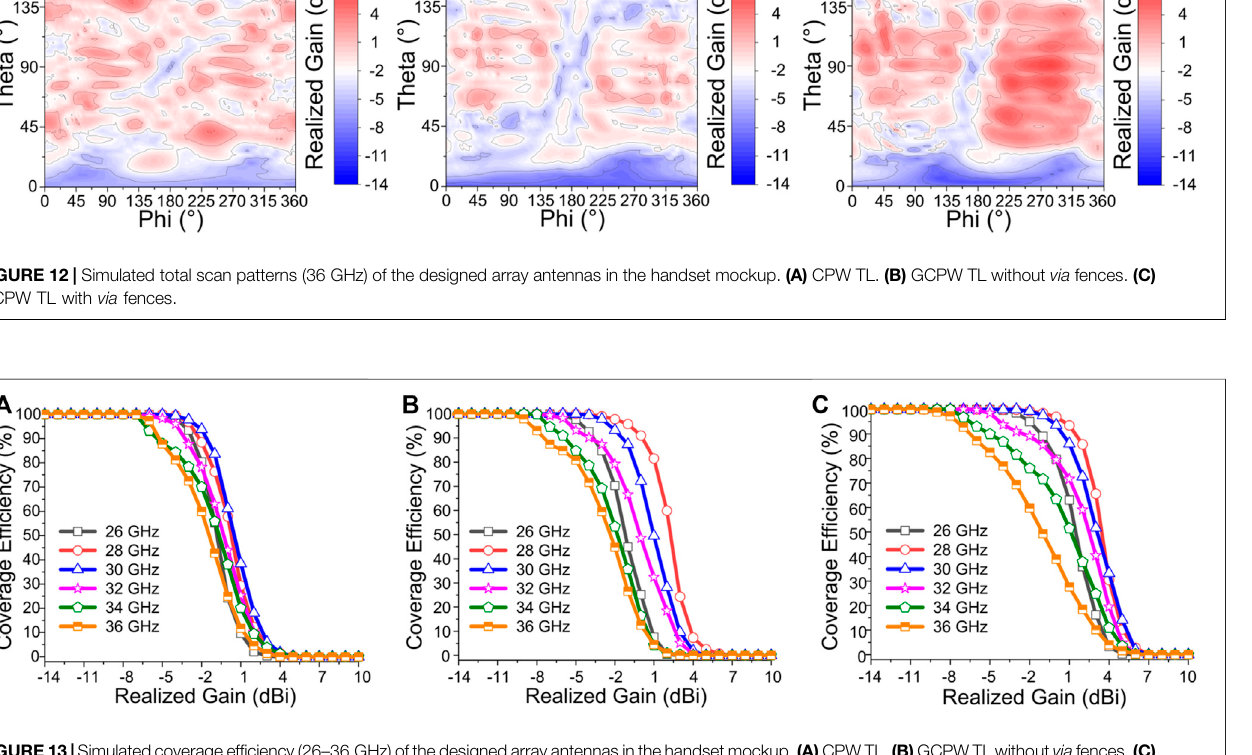
FIGURE13| Simulatedcoverageef fi ciency(26 – 36 GHz)ofthedesignedarrayantennasinthehandsetmockup. (A) CPWTL. (B) GCPWTLwithout via fences. (C) GCPW TL with via fences.